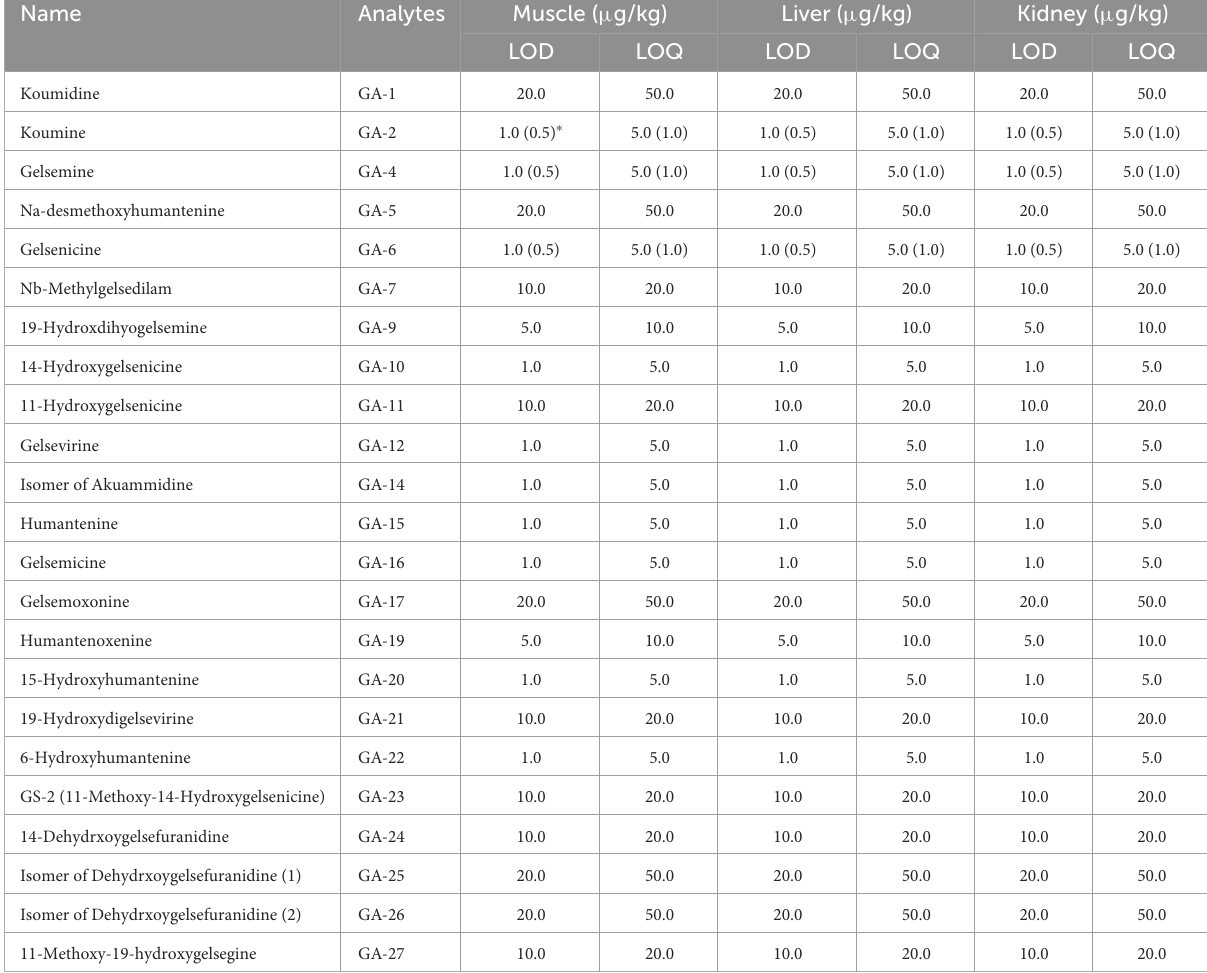
TABLE 1 LODs and LOQs for G. elegans alkaloids in different matrices (muscle, liver, and